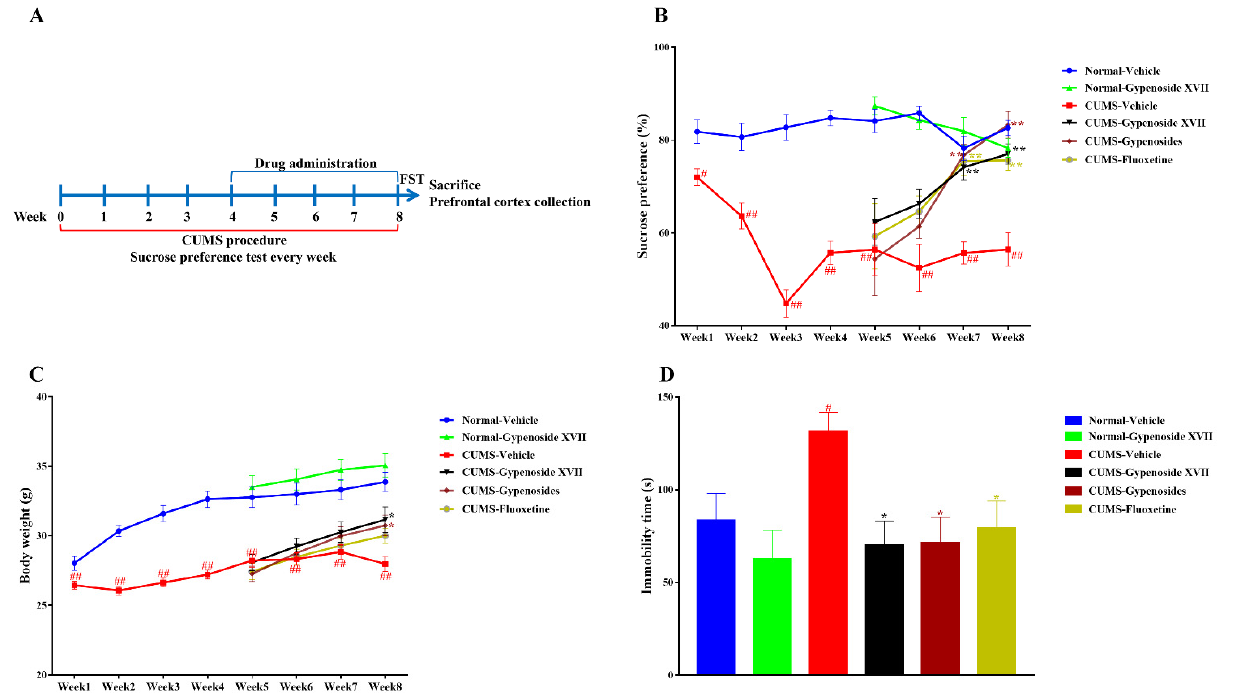
Figure 2. Gypenoside XVII reversed depression-like symptoms in depression-like mice ( n = 10). Diagram for the experimental protocol ( A ). Sucrose preference during an 8-week CUMS procedure ( B ). Body weight during an 8-week CUMS procedure ( C ). Immobility time at the end of CUMS procedure ( D ). # p < 0.05 and ## p < 0.01 versus the Normal-vehicle group. * p < 0.05 and ** p < 0.01 versus the CUMS ‐ vehicle group.